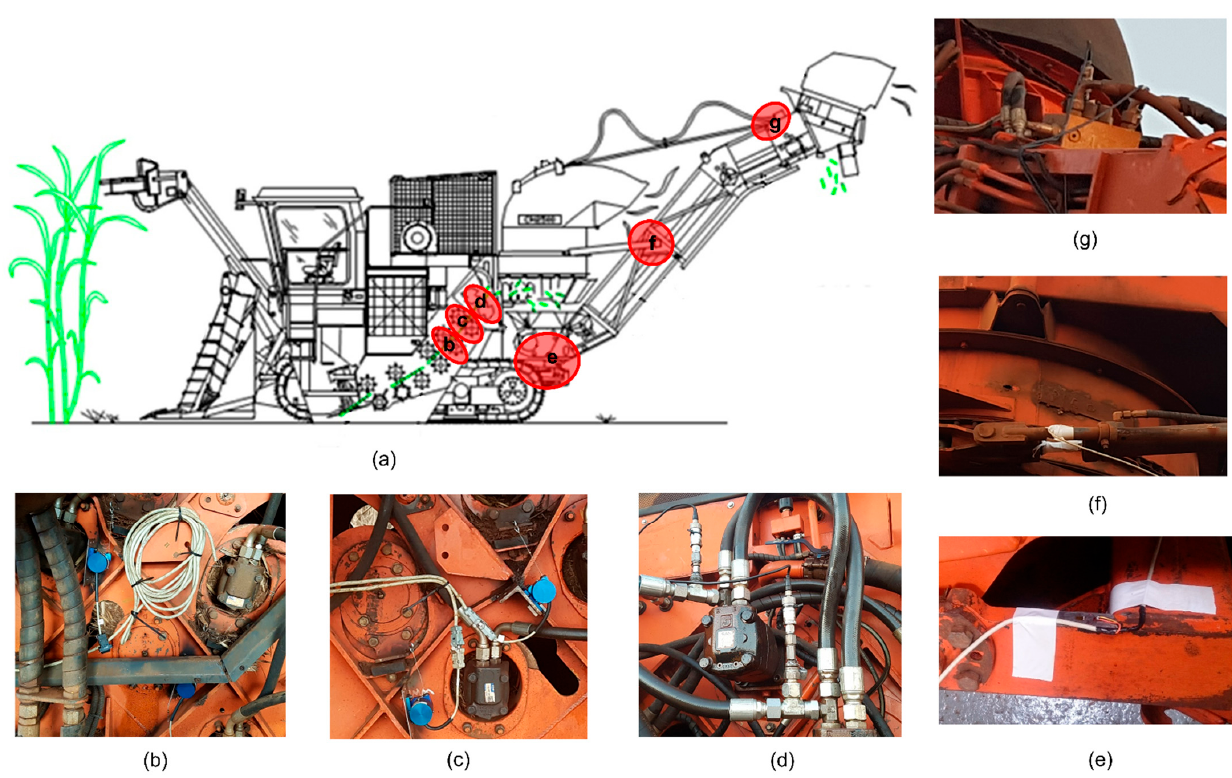
Figure 3. Sensor locations in the harvester ( a ). Potentiometric displacement sensor in the roll feeder number 1 ( b ) and roll feed number 2 ( c ). The pressure sensor in the hydraulic motor of the chopper ( d ). Strain gauges in the elevator base ( e ) and the hydraulic cylinder of the elevator ( f ). The pressure sensor in the hydraulic motor of the elevator ( g ).